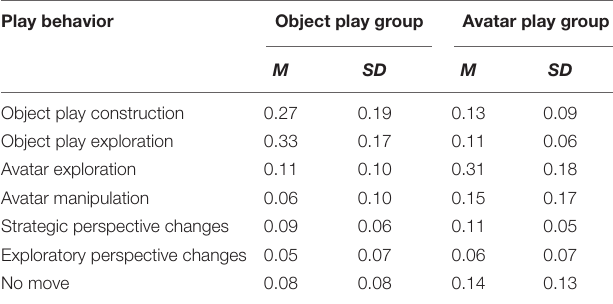
TABLE 3 | Means and standard deviations of the proportion of time children spent in each play behavior by